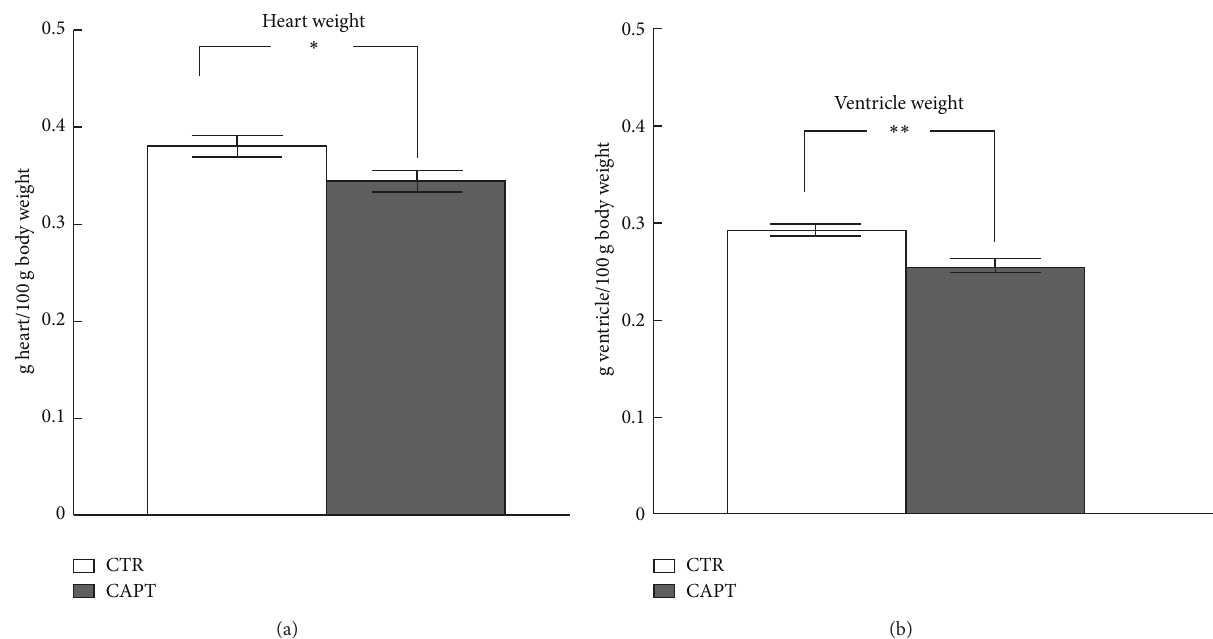
Figure 1: Total heart and left ventricle weight (g) in control (CTR) and captopril- (CAPT-) treated animals, as measured at the end of the treatment period (four weeks). The values represent the mean ± SEM of 10 animals in each group. ∗ 𝑃 < 0.05 ; ∗∗ 𝑃 < 0.01